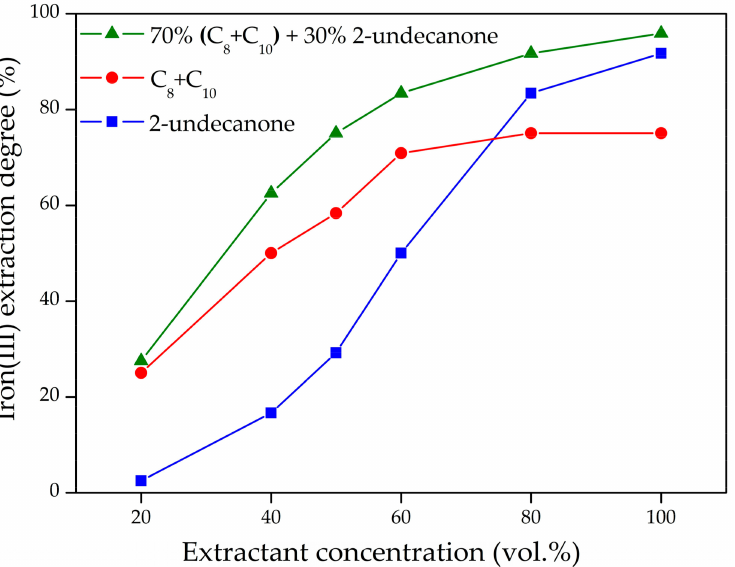
Figure 5. Effect of extractant concentration on iron(III) extraction at C(HCl) = 5.7 M, C(Fe) = 8.4 g/L, O:A =